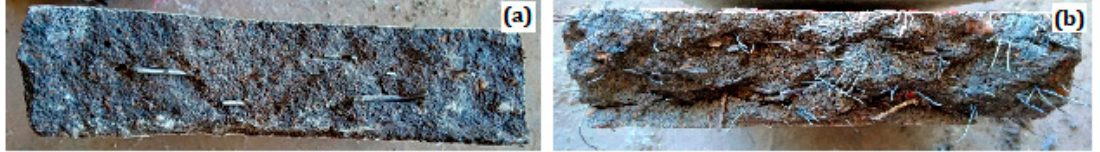
Figure 12. Failure mode of all teste ferrocement panel under impact load.